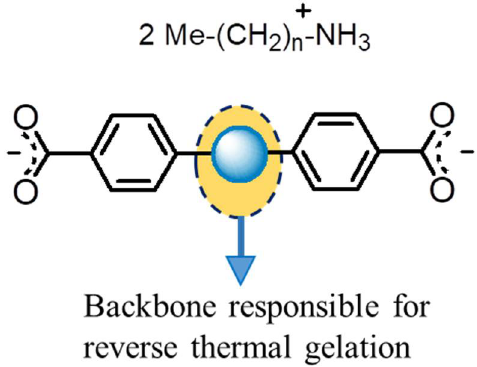
Figure 2. The schematic presentation of a dicarboxylic acid that can show heat-set gelling behavior. When a specific backbone such as azo, amide, urea, or bipyridine is used, the resultant dicarboxylic acid would be generally poorly soluble in methanol and does not exhibit the same melting point; they generally decomposes at around 350 °C.